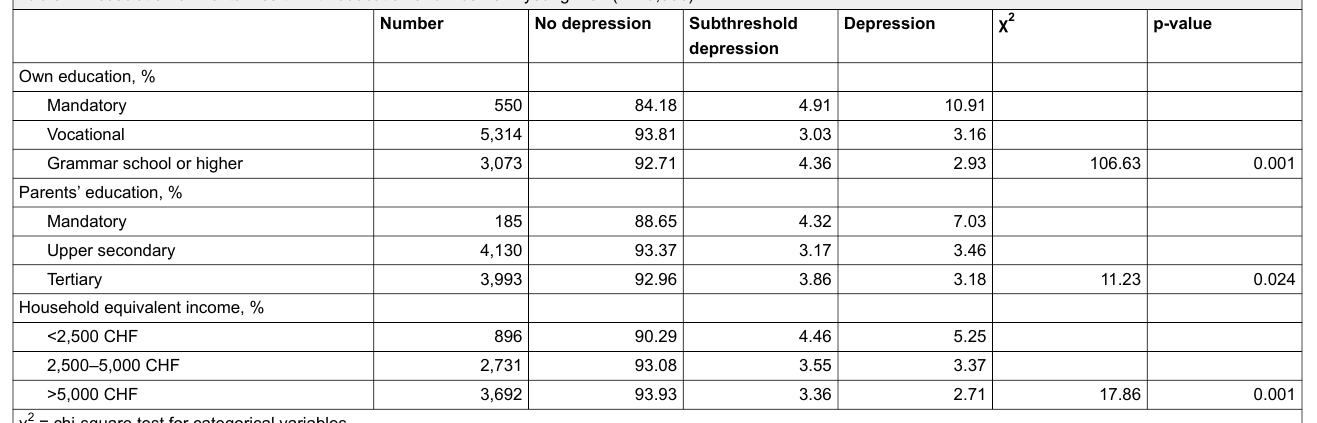
Table 1: Association of mental health with education and income in young men (n = 9,066).